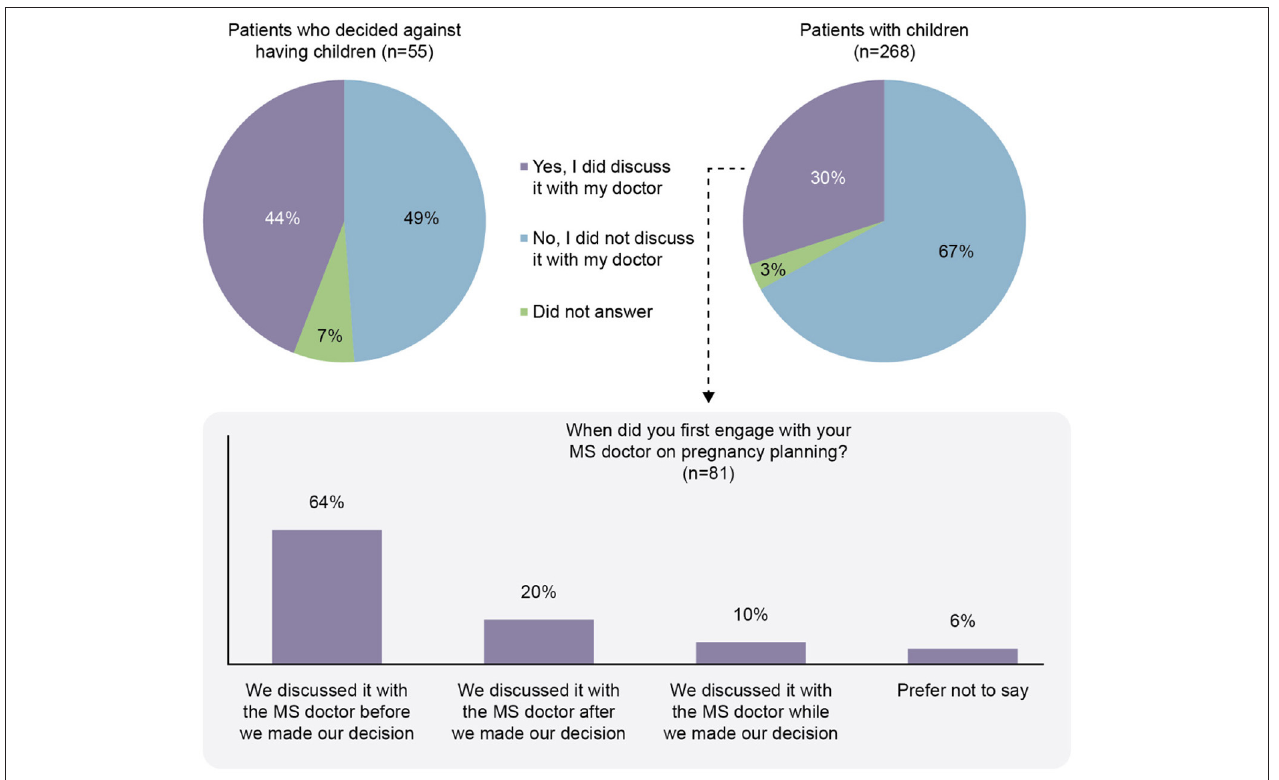
FIGURE 6 | Discussion of family planning with the doctor responsible for management of the participant with multiple sclerosis